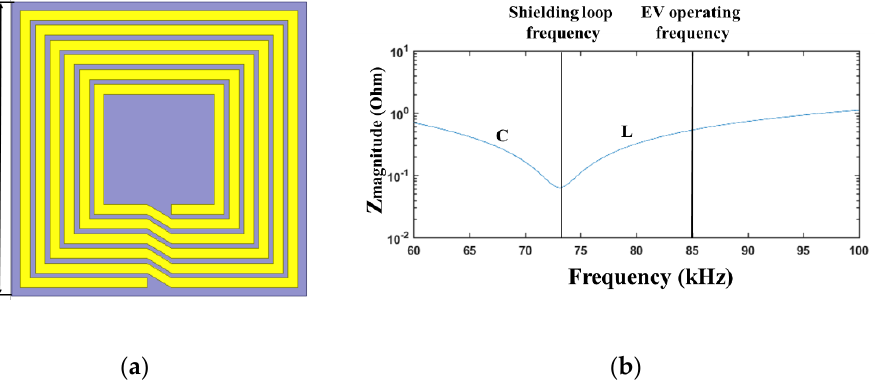
Figure 3. ( a ) Structure of the unit cell. ( b ) Magnitude of the impedance in the shielding metamaterial. Therefore, the effective permeability of the low-frequency metamaterial is drawn as in Figure 4.